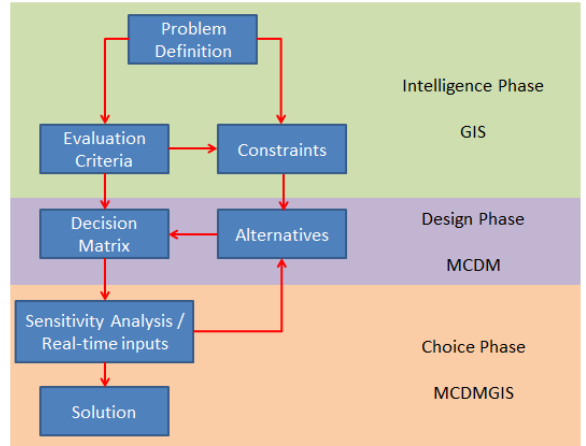
Figure 1. Multicrititeria decision making flowchart